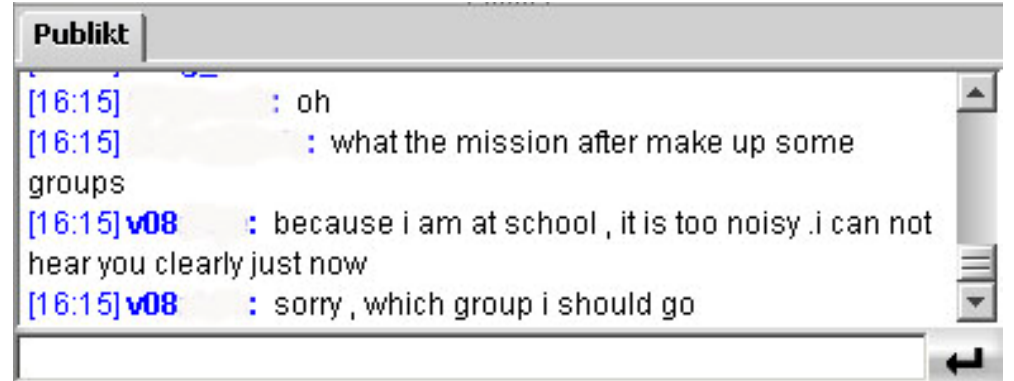
Figure 4 . Noisy surroundings (names removed from